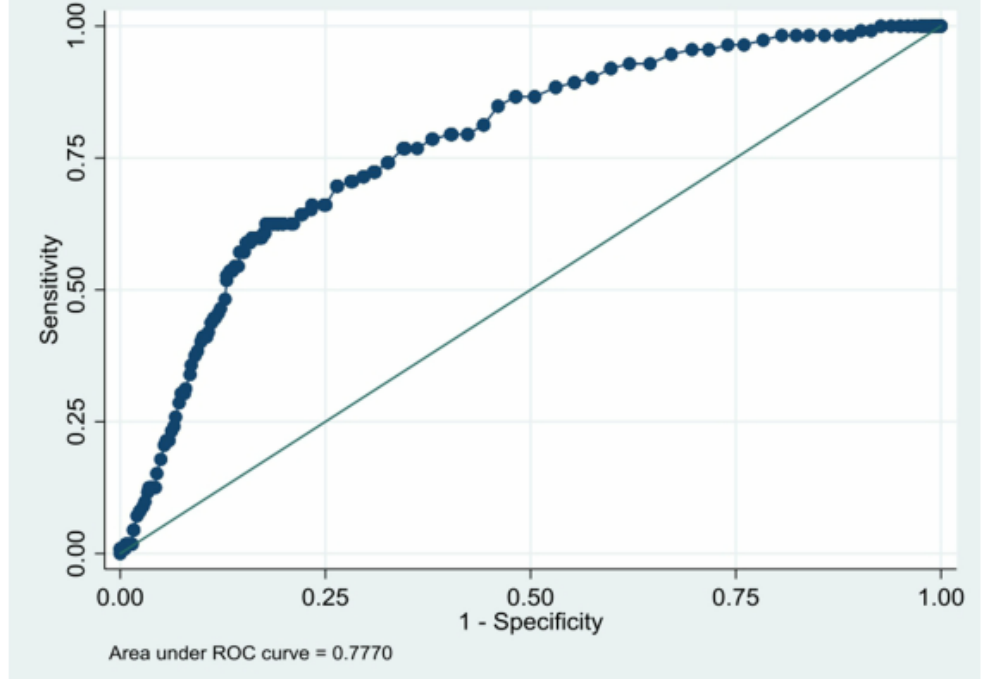
Figure 2. ROC curve for the identification of patients with in-hospital bleeding in the development dataset. ROC: receiver operating characteristic.